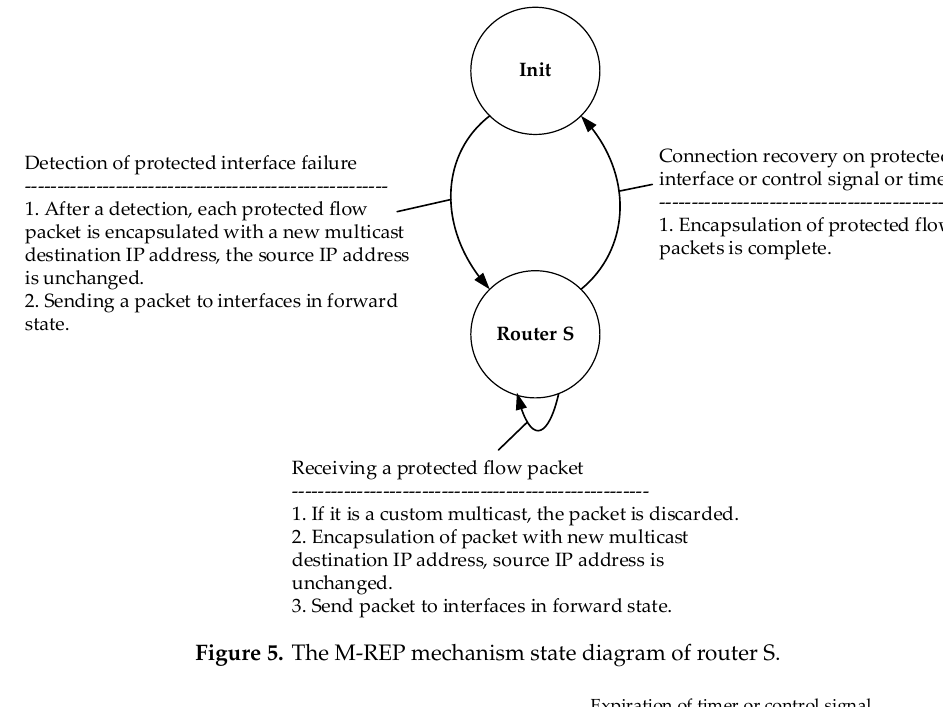
Figure 5. The M-REP mechanism state diagram of router S. Sensors 2020 , 20